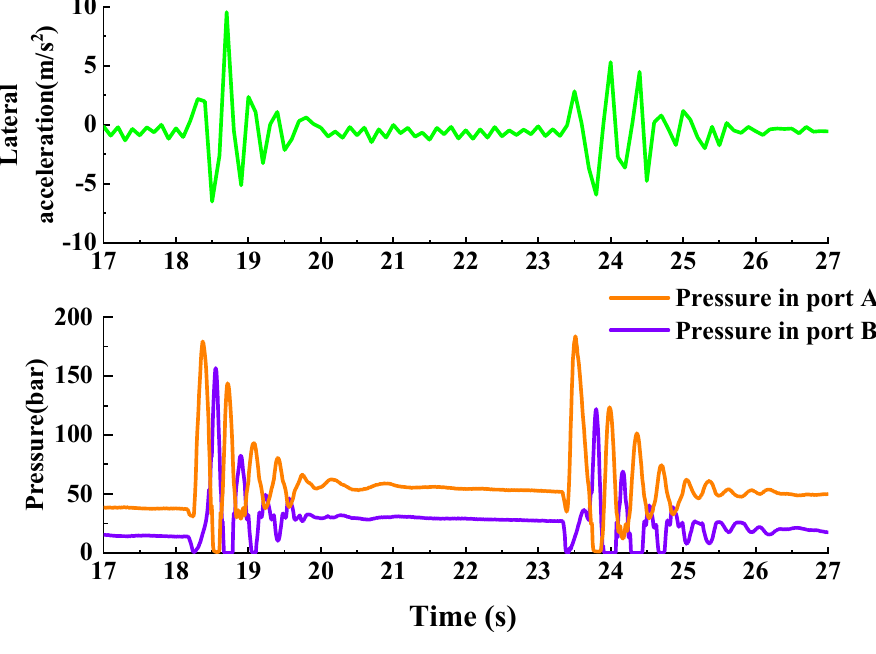
Figure 5. Prototype test results.